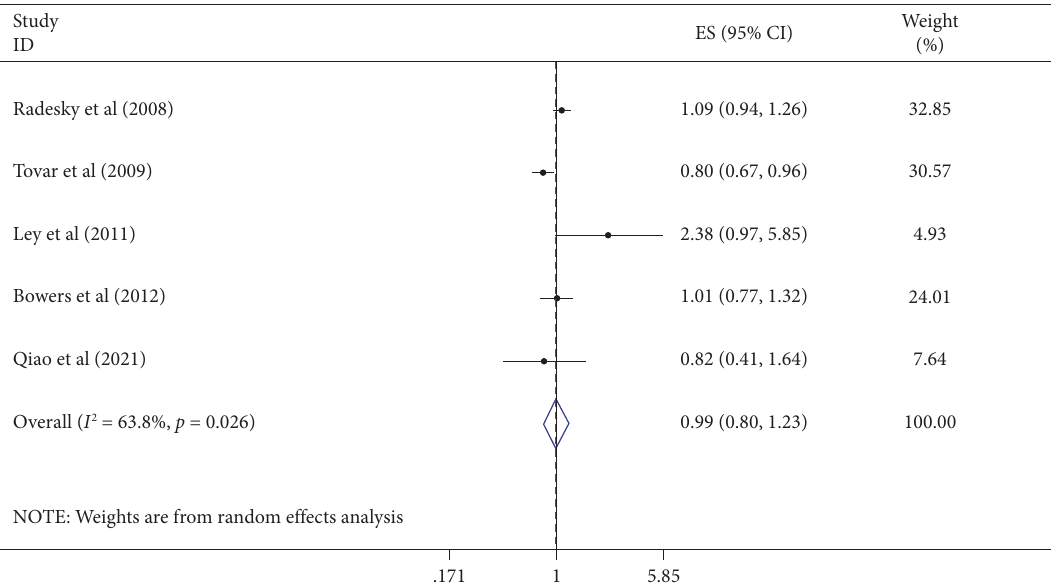
Figure 2: Forest plot derived from random-efects meta-analysis of cohort studies investigating the association between high versus low intake of total protein consumption and gestational diabetes mellitus. CI, confdence interval; ES, efect